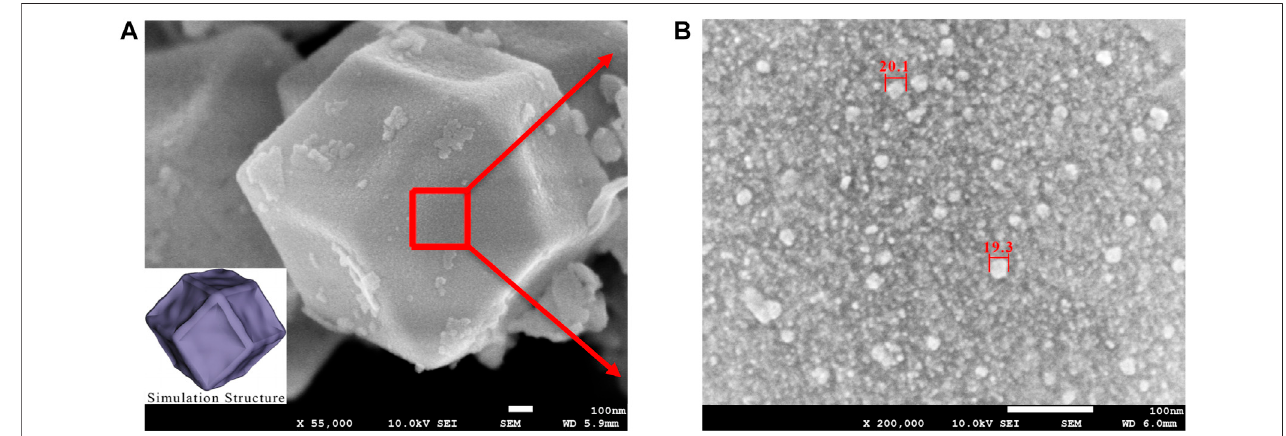
FIGURE 6 | Performance curves of different CoFe-ZIF(-W) samples for catalytic oxidation of α -pinene (A) catalytic ef fi ciency of CoFe-ZIF samples (B) catalytic ef fi ciency of CoFe-ZIF-W samples (C) energy ef fi ciency of CoFe-ZIF samples (D) energy ef fi ciency of CoFe-ZIF-W samples.